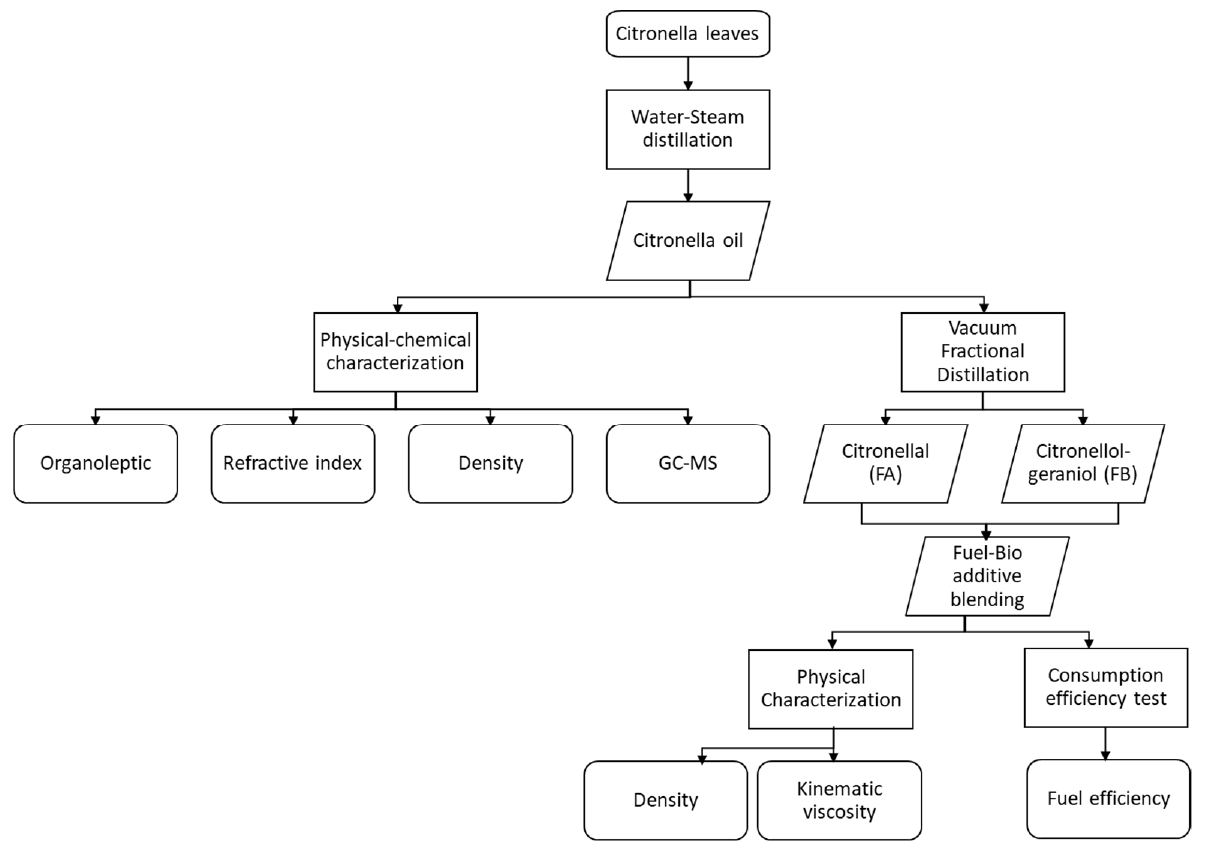
Figure 1. Flow chart of research.